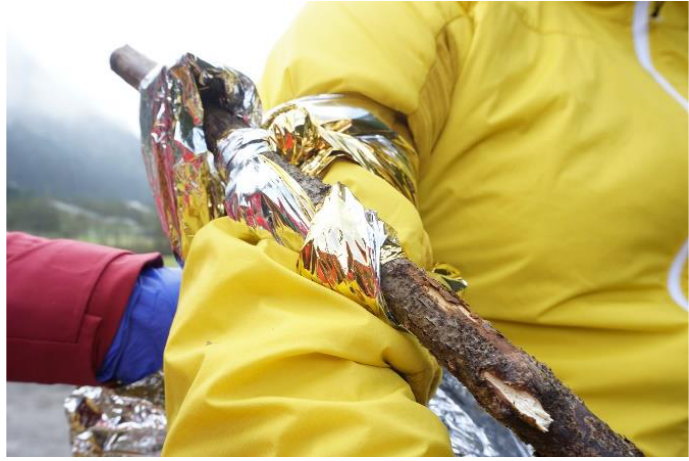
Figure 5. Application of a rescue blanket as tourniquet.